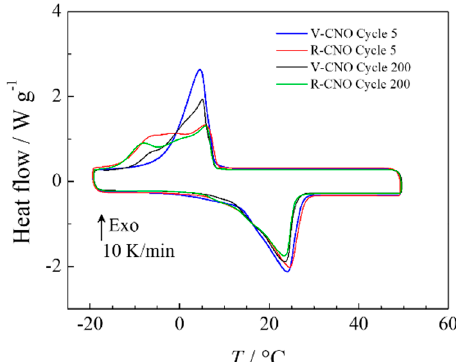
Figure 5. DSC thermograms of R-CNO and V-CNO after 5 and 200 melt-freeze cycles show similar changes in melting (endothermic) peaks in response to thermal cycling and similar melting behavior for a given cycle but different solidification (exothermic) behavior for the two types of coconut oil.